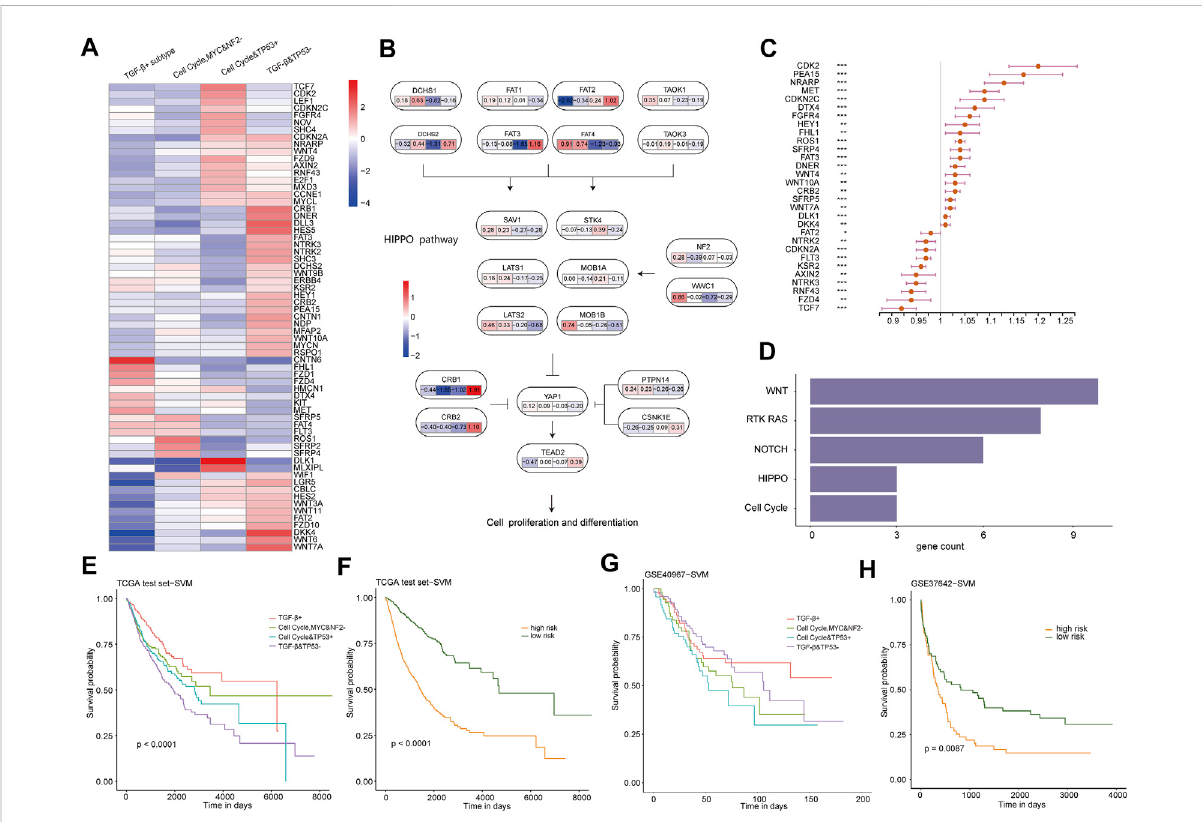
FIGURE 3 (A) Heat map of the log2FC value of differentially expressed genes in four subtypes. (FC, fold change, the ratio of the average mRNA expression for each cancer pathway – related subtype to the average mRNA expression for samples not of the aforementione subtype. Red, upregulated; blue, downregulated.). (B) Interaction ofgenes intheHIPPO pathwayandtheFC valueofthefour subtypes ofthegene. (C) Forest plotof multivariate Cox regressionanalysis for 30 genes related to prognosis. The hazard ratios are shown with 95% con fi dence intervals (*** p < 0.001; ** p < 0.01; * p < 0.05; and p < 0.1). (D) Pathways in which 30 differentially expressed genes are enriched. (E) KM survival curves of the subtype classi fi er constructed using samples from TCGA test cohort by the SVM method. (F) KM survival curves of the prognosis classi fi er constructed using samples from